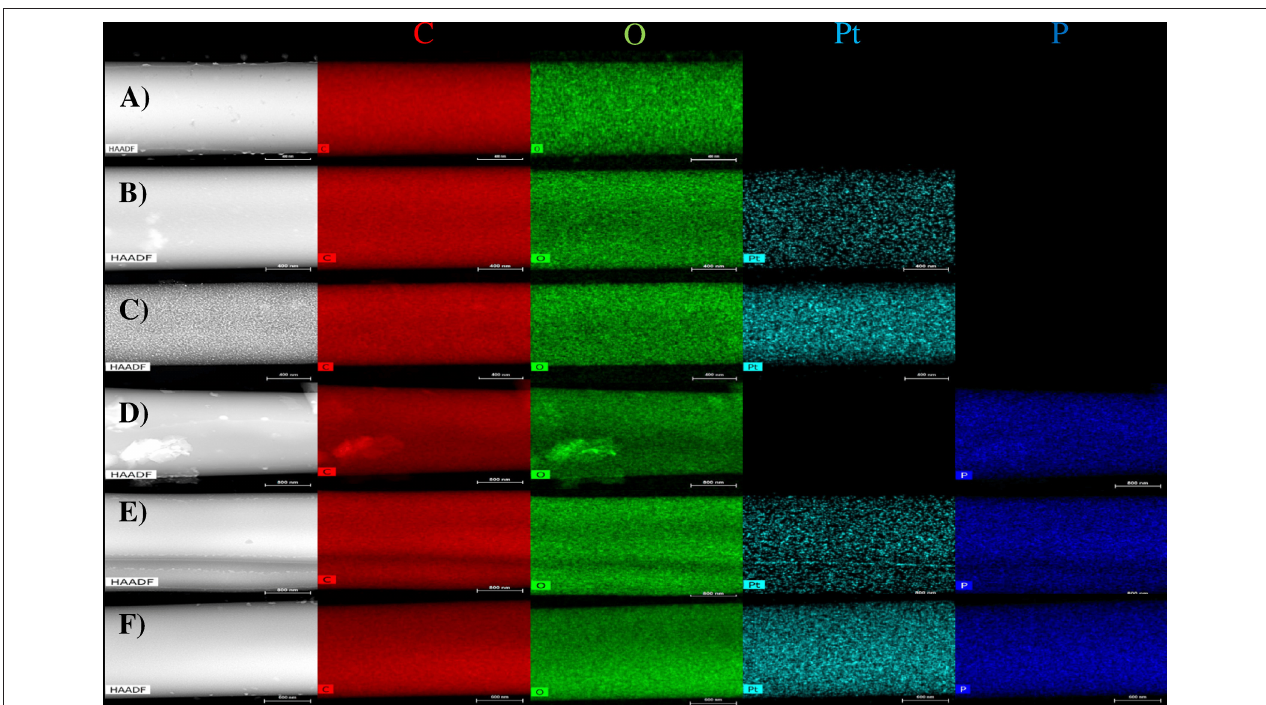
FIGURE 11 | EDX mapping of: free metal, low and high Pt concentration in CFs (A–C) , respectively); and PCFs (D–F) , respectively).